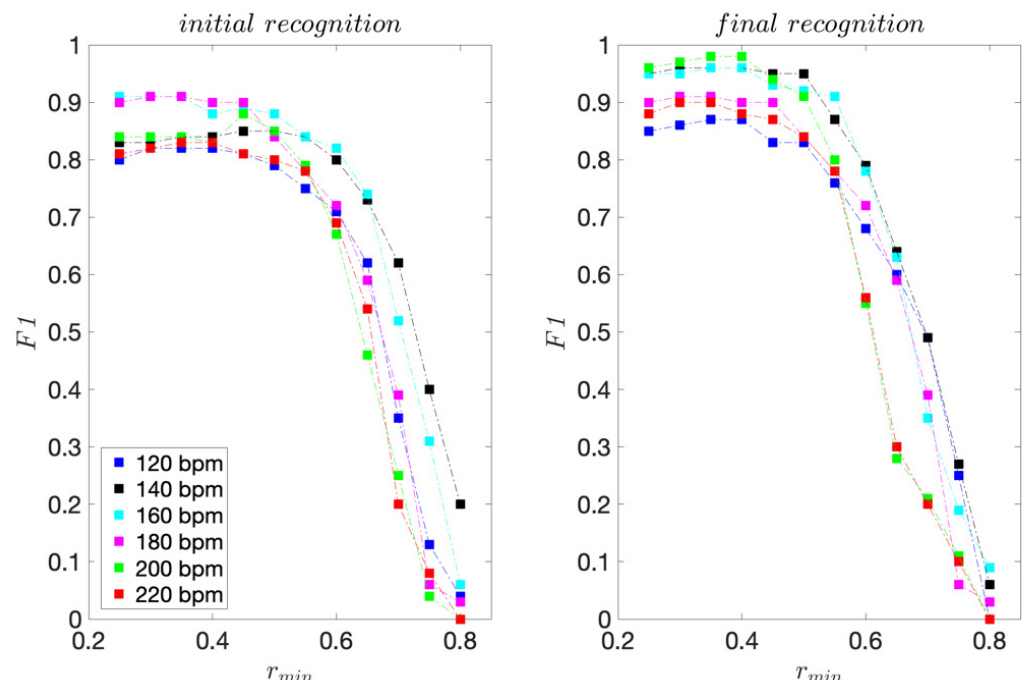
Figure 5. F1 scores obtained for the professional dancer’s test sequences.